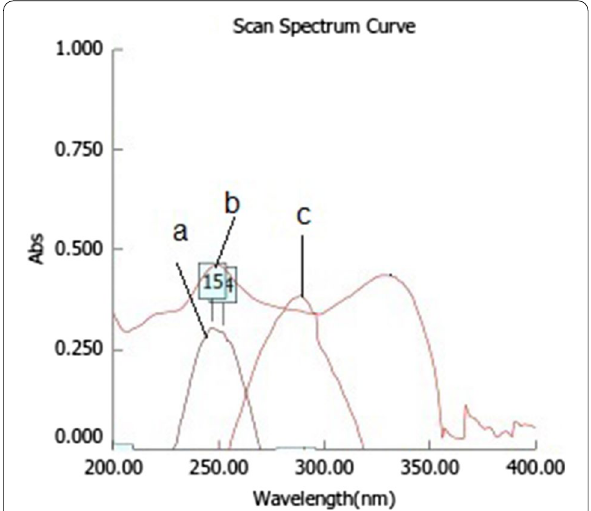
Fig. 6 UV spectrum wavelength selection of a metsulfuron-methyl, b chlorantraniliprole and c